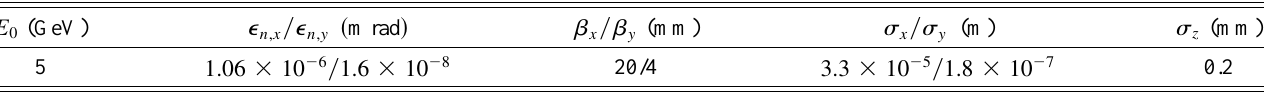
TABLE III. Parameters of the electron beam for laser-Compton cooling at E 0 (cid:1) 5 GeV and C (cid:1) 5 for the optics design. (cid:3) e (cid:1) m rad E 0 (GeV) e n , x n , y